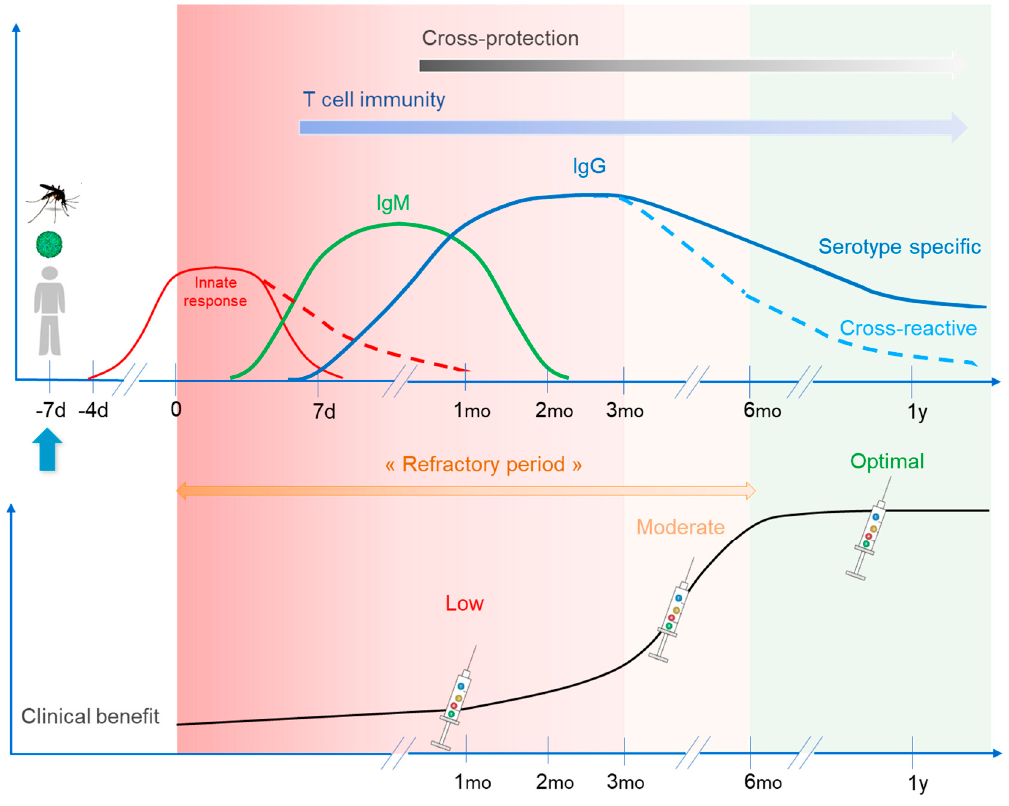
Figure 3. Wild type infection-induced responses will install a “refractory period” during which they would block or lower live-attenuated vaccine take and subsequent immunity/efficacy. Innate response would totally block any vaccine replication should it be given during the initial steps of infection, but IgM/IgG and T cell responses could still hamper vaccine take during the following weeks and months. When wild type-induced responses wane—cross-reactive responses in first place—this leaves more room for live vaccines to establish proper immunity, and they can even enhance it.